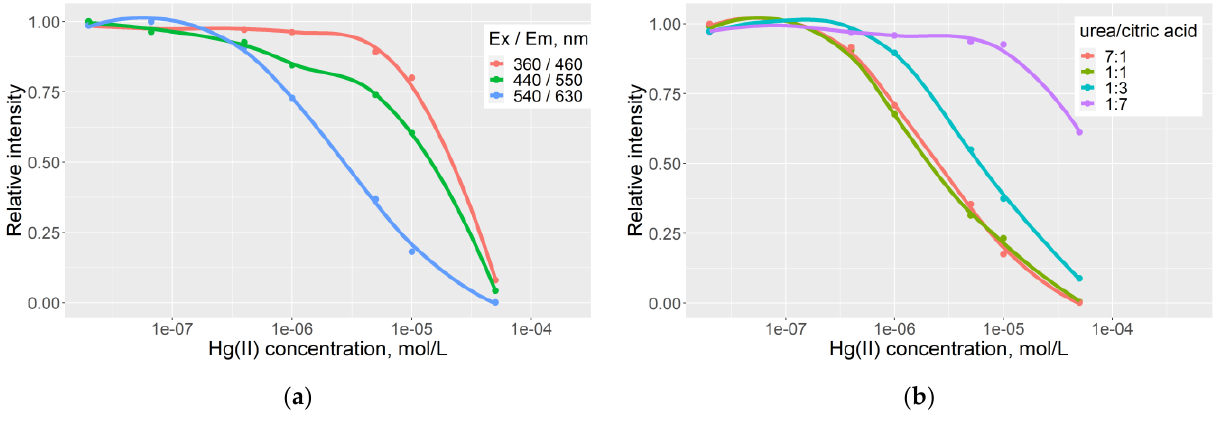
Figure 11. Relative intensity of emission of purified samples prepared from urea and citric acid as a function of Hg(NO 3 ) 2 concentration. (a) The 7:1 sample with different combinations of excitation and emission wavelengths (shown in the legend). (b) Samples of different composition (shown in the legend). Optimal combinations of excitation and emission wavelengths were estimated from the plots in Figure 9 as follows: λ ex 560 nm, λ em 630 nm (7:1), λ ex 460 nm, λ em 550 nm (1:1 and 1:3), and λ ex 340 nm, λ em 420 nm (1:7).